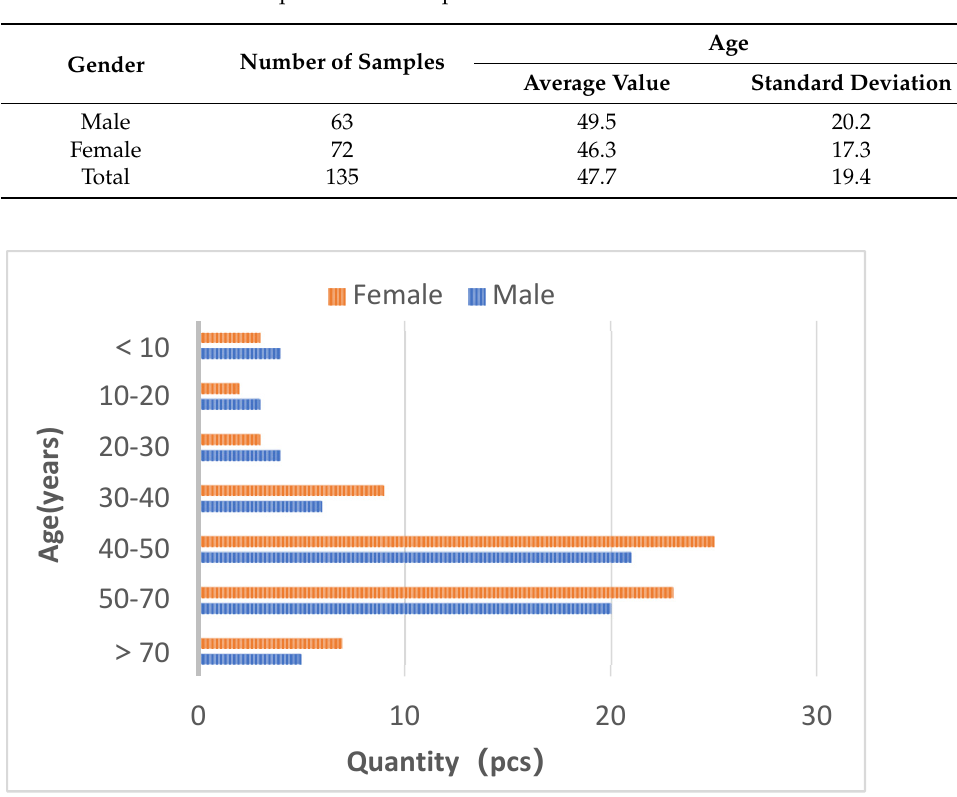
Figure 4. Gender and age distribution of interviewees.